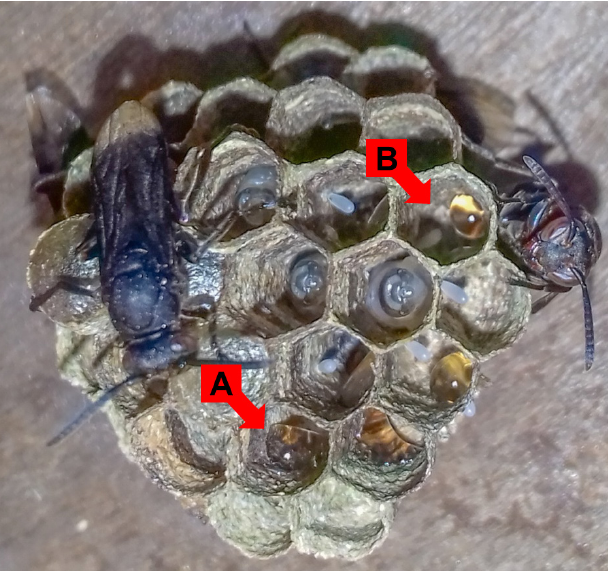
Fig 1 . Honey storage inside the cells of a Mischocyttarus socialis nest in post-emergence phase: (A) storage in empty cells and (B) storage in egg cells.